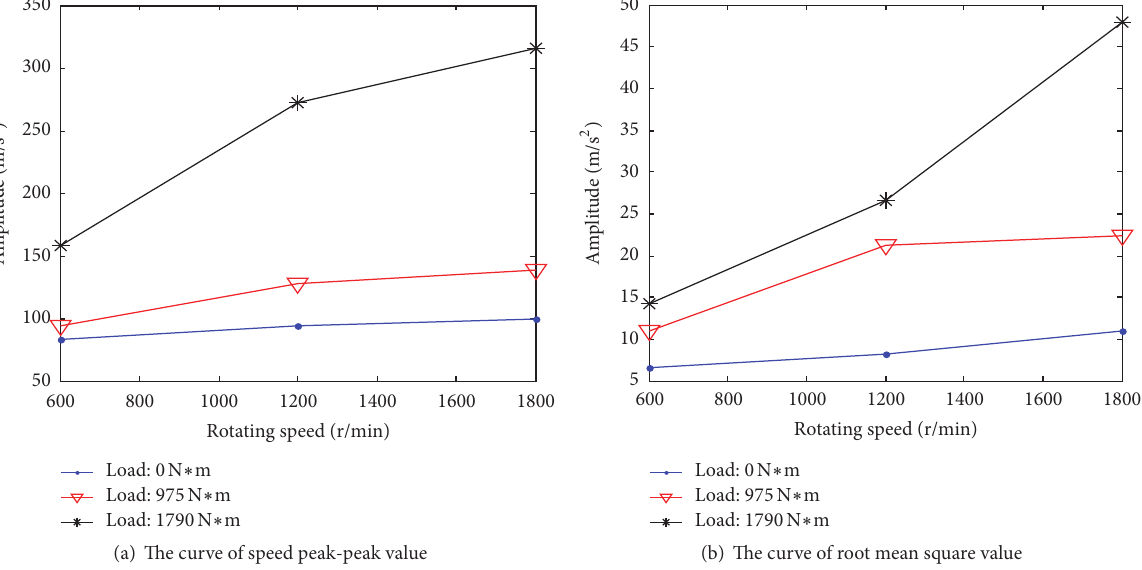
Figure 4: Broken teeth-pitting compound fault